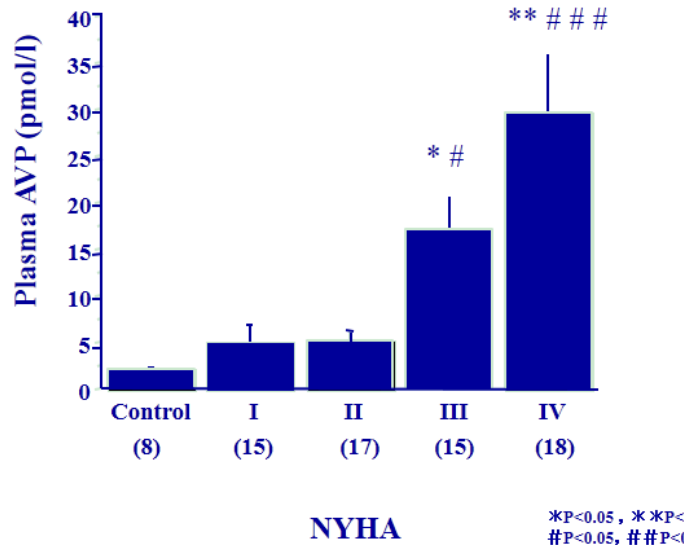
Figure 3. Distribution of Plasma AVP levels in the 65 patients with congestive heart failure. Cited from [27].